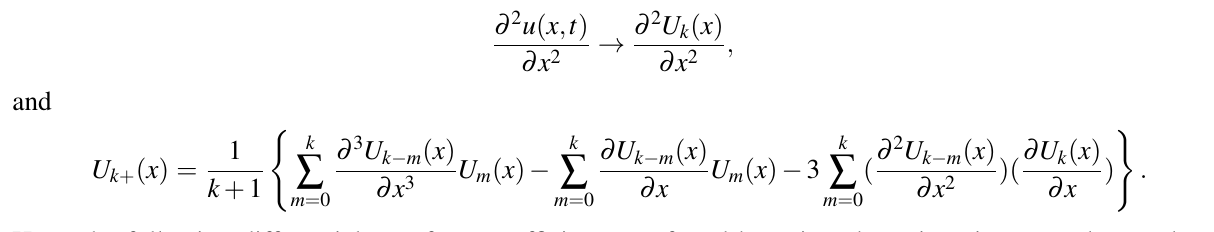
Fig. 3 The Comparison of Exact, Hybrid Method and RDTM for t = 0 ,